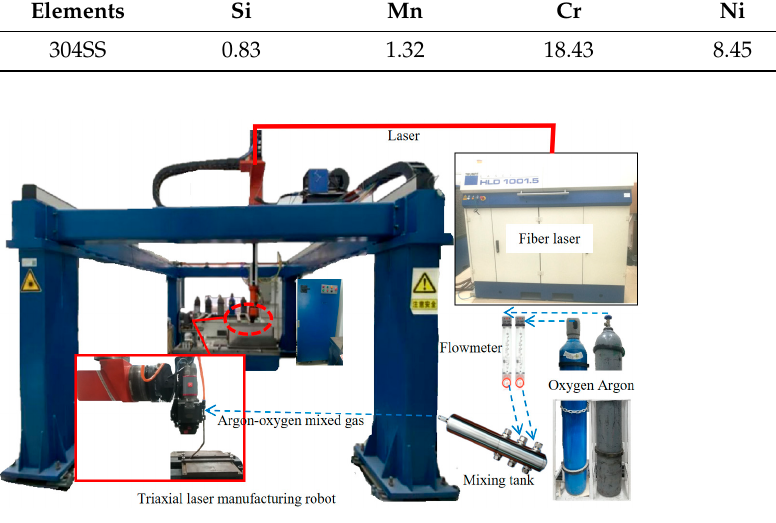
Figure 1. Experimental setup of laser welding.